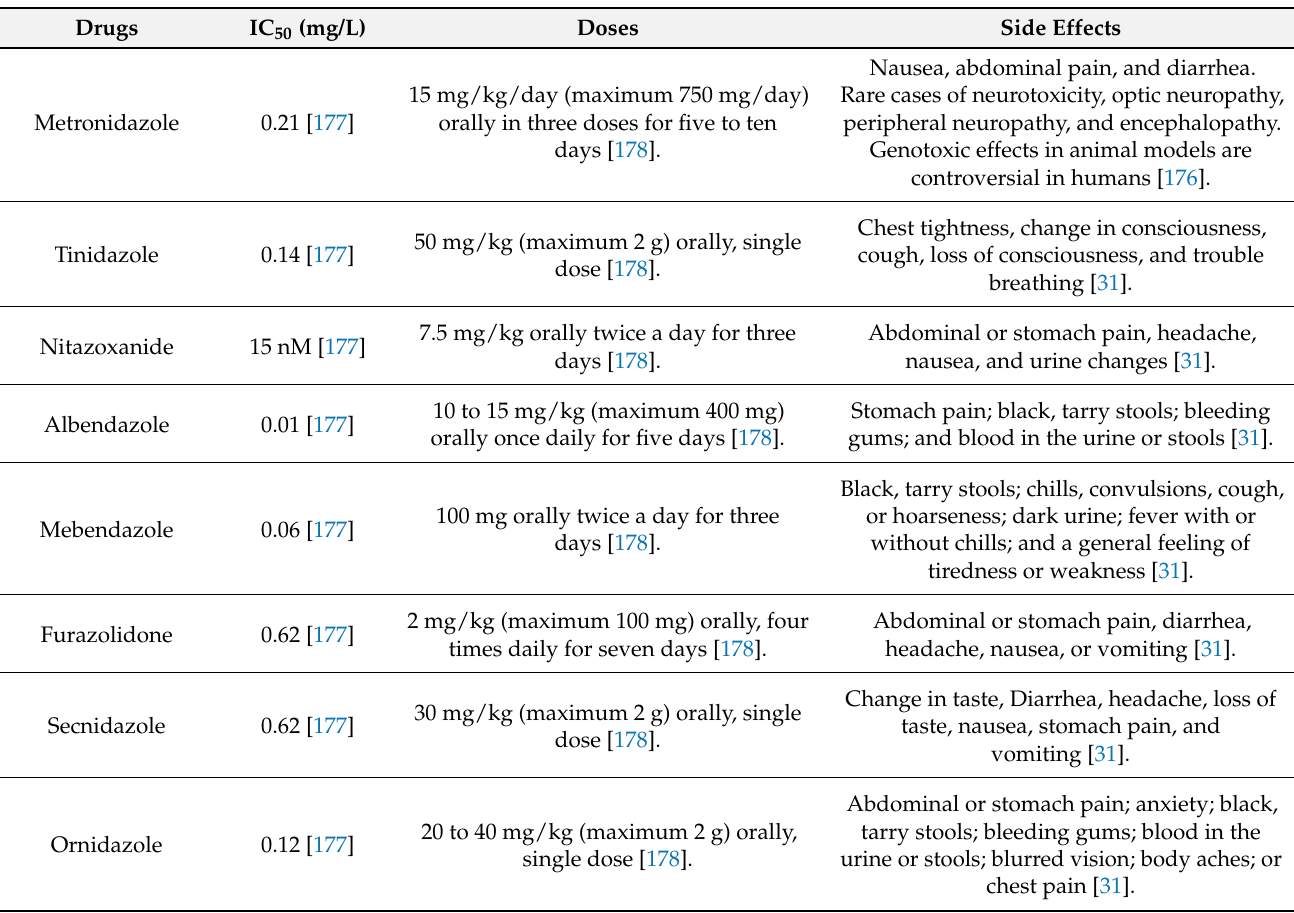
Table 5. Biological activity, dose, and adverse effects of drugs used against